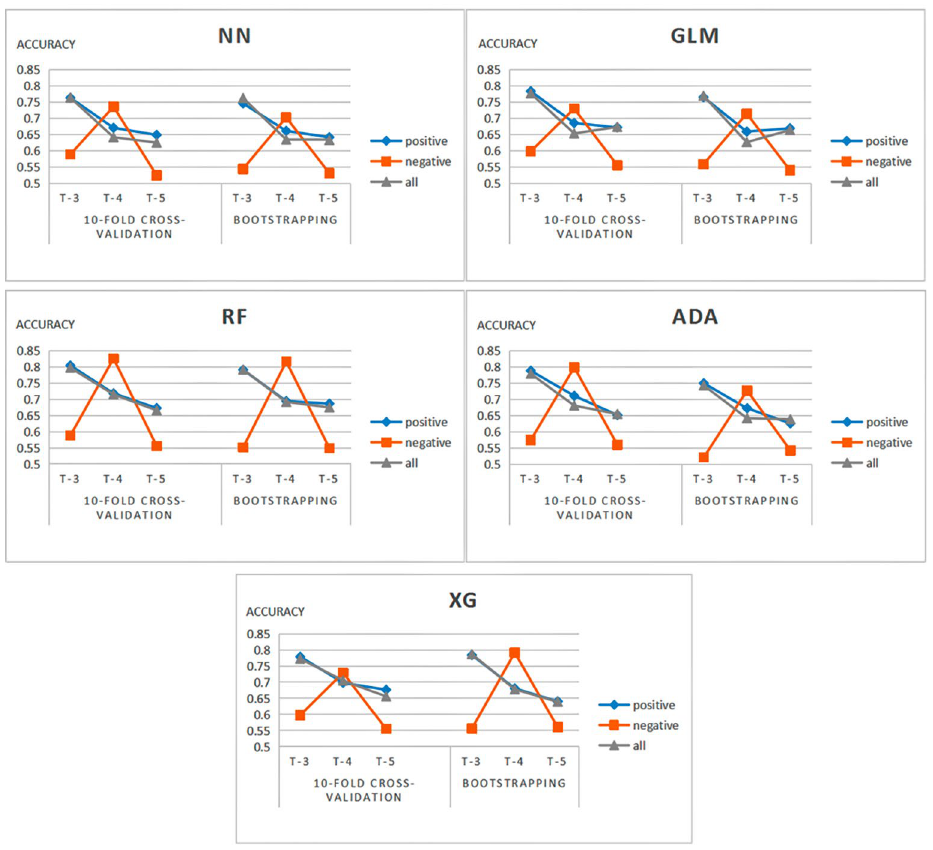
Figure 3. Sensitivity analysis of different methods (Three kinds of